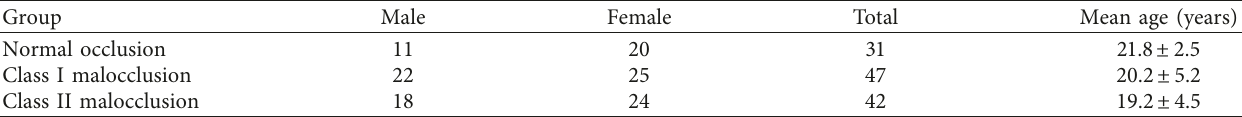
Table 1: Group characteristics.